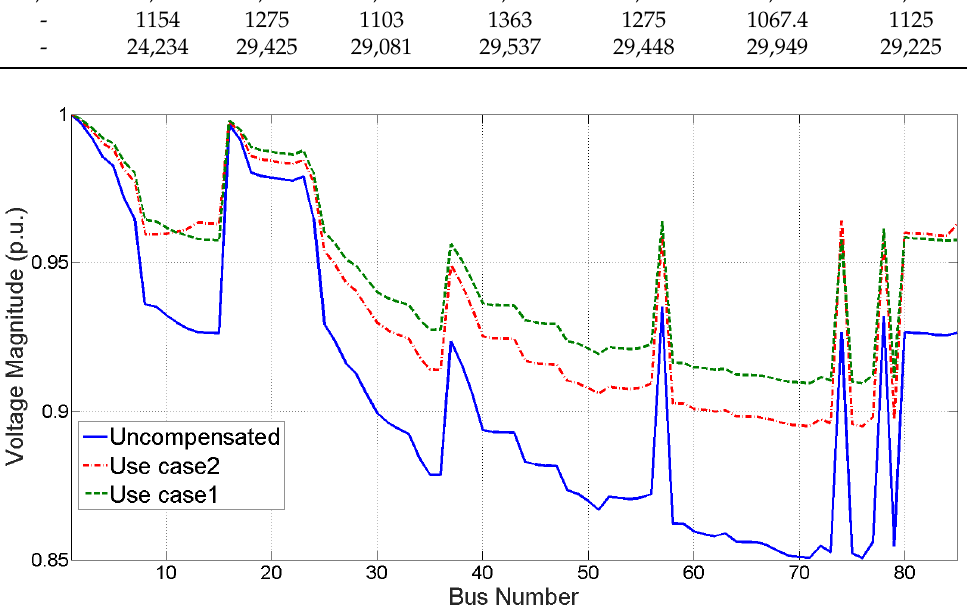
Figure 8. Voltage profile for N 2 in CS 1